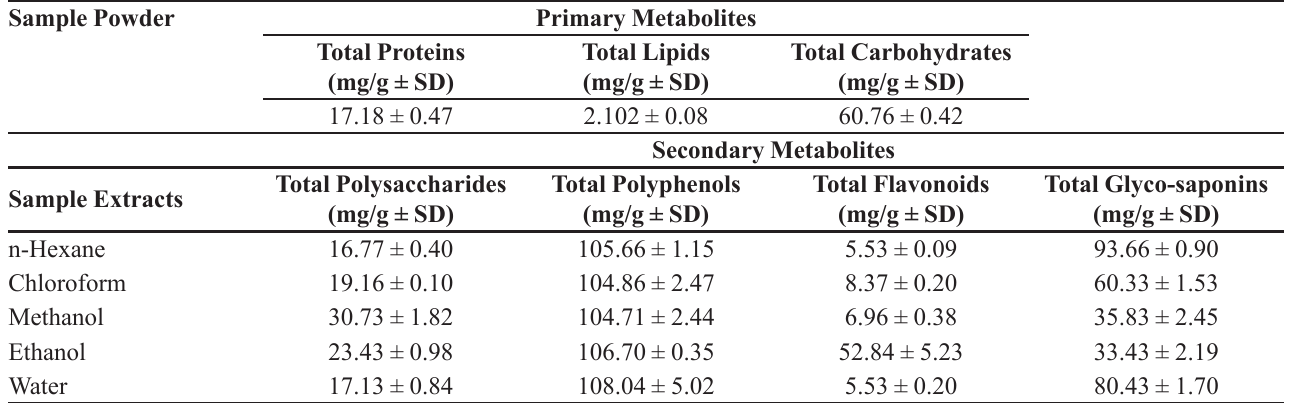
TABLE II - Estimation of primary & secondary metabolites of powdered leaves of Acacia modesta